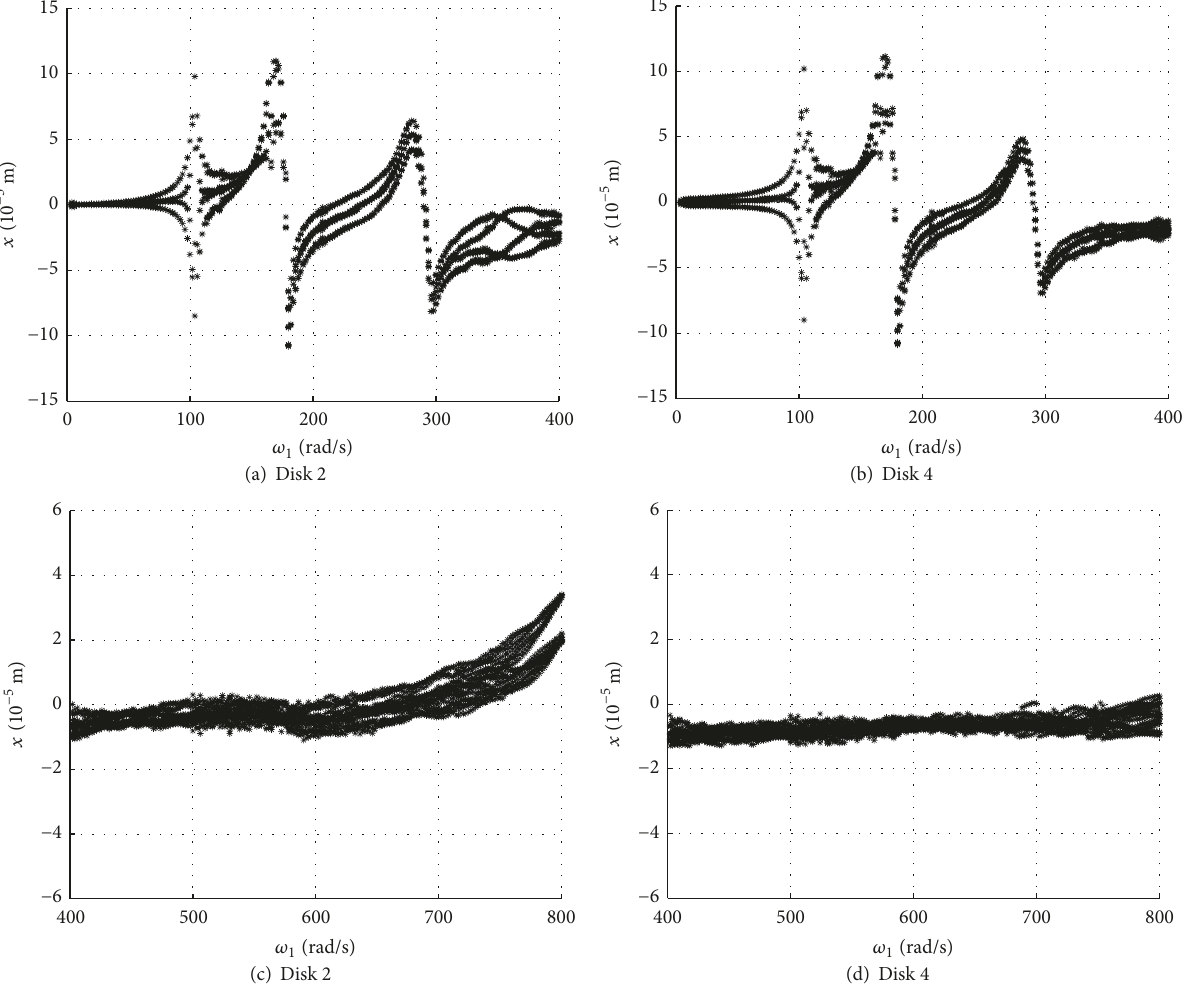
Figure 8: Bifurcation diagrams of the horizontal response of disk 2 and disk 4 with rotor speed. 𝜆 = −1.65